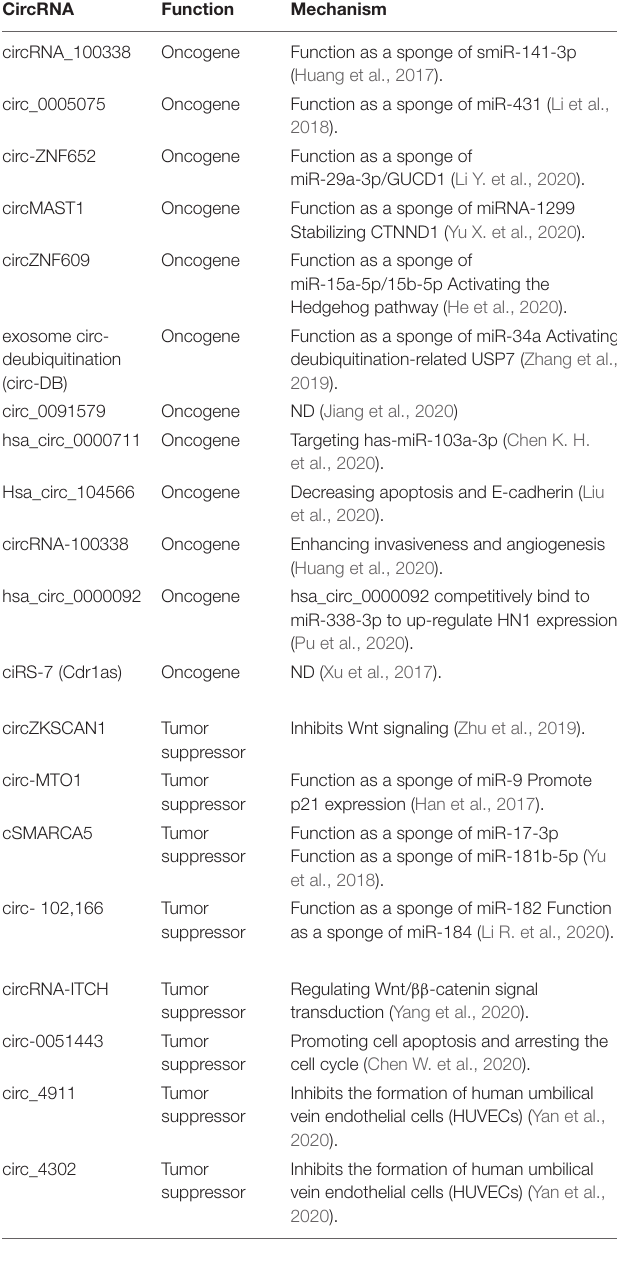
TABLE 2 | Representative circRNAs in the regulation of HCC. CircRNA Function